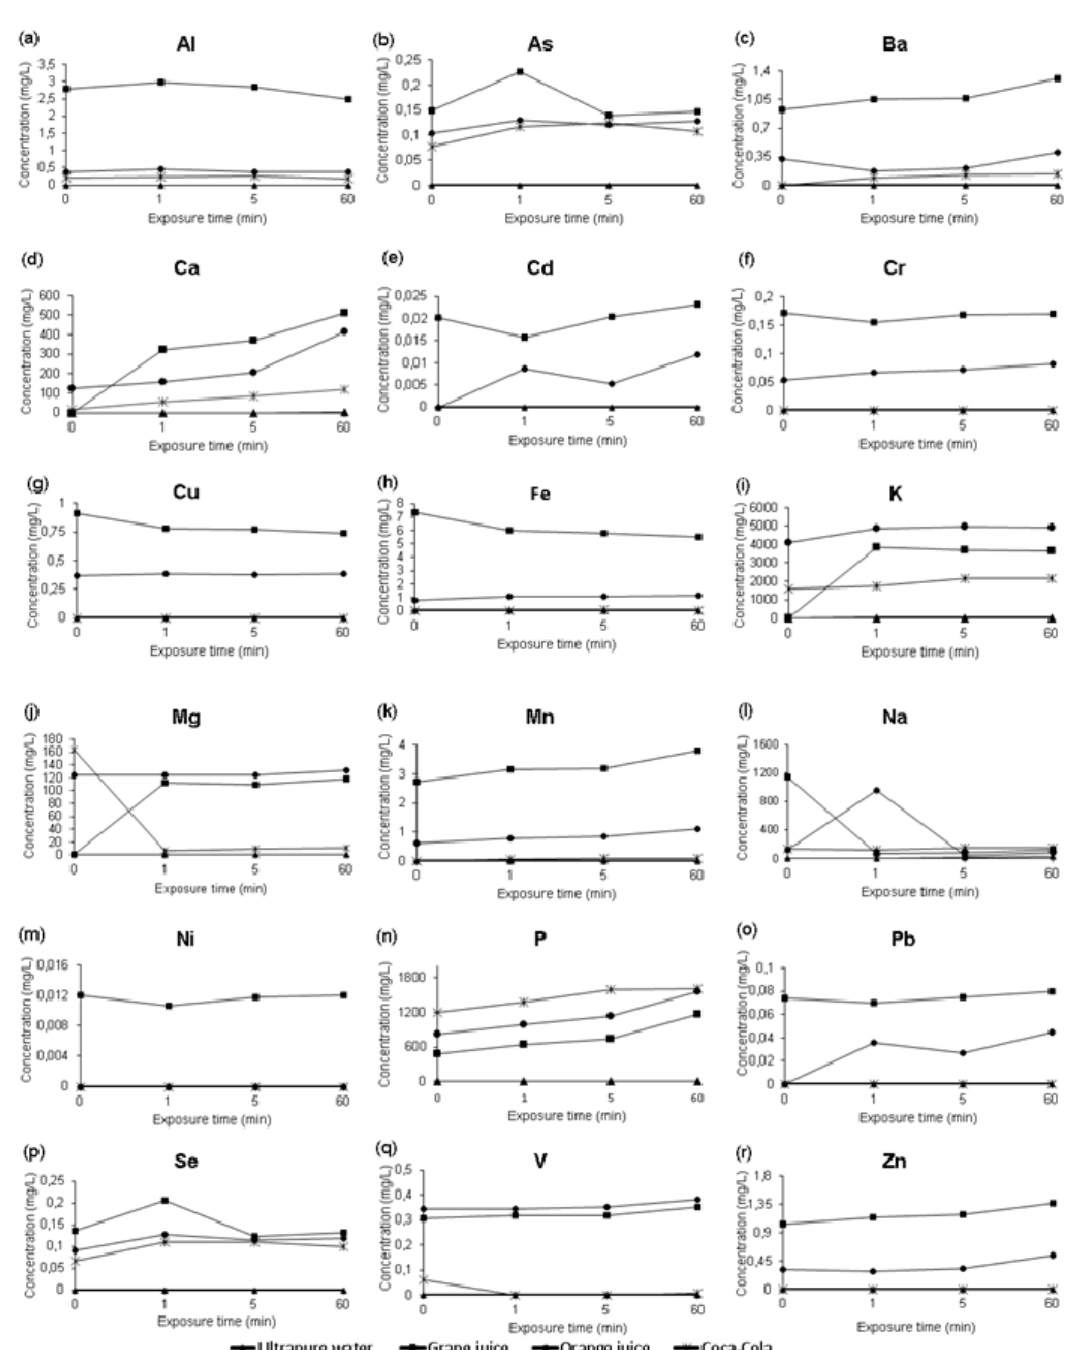
Figure 1. Elemental concentration in beverages from demineralization/remineralization process over time. ( a ) Al. ( b ) As. ( c ) Ba. ( d ) Ca. ( e ) Cd. ( f ) Cr. ( g ) Cu. ( h ) Fe. ( i ) K. ( j ) Mg. ( k ) Mn. ( l ) Na. ( m ) Ni. ( n ) P. ( o ) Pb. ( p ) Se. ( q ) V. ( r )